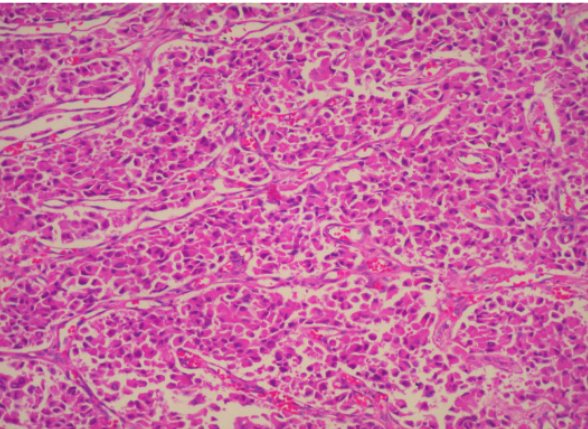
Figure 3 - Micrograph of a histological section of the pancreatic tumor showing monomorphic tumor cells growing in an organoid pattern characterized by nests, sheets, and ribbons. The tumor cells are small, round to oval, with nuclei showing “salt and pepper” chromatin and with prominent granular eosinophilic cytoplasm. The histological pattern is consistent with a carcinoid tumor (hematoxilin & eosin staining; original magnification, X200)